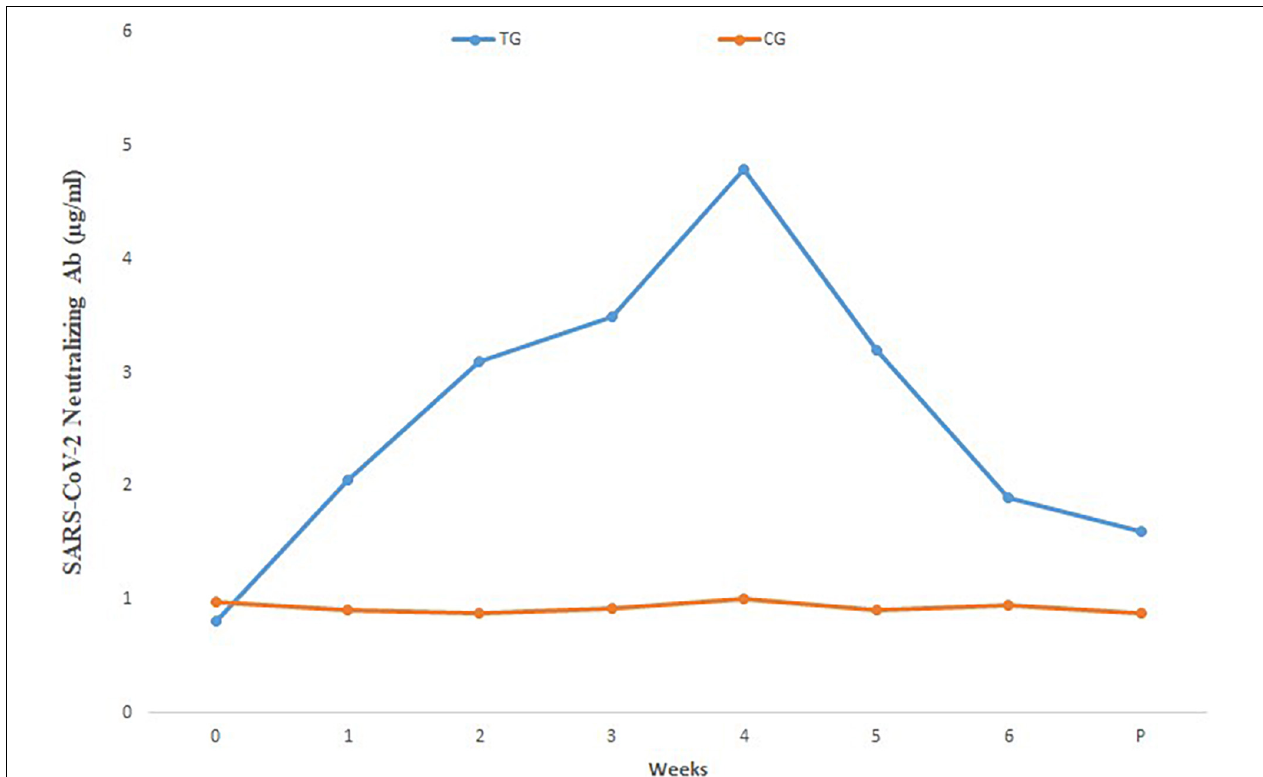
FIGURE 3 | Mean SARS-CoV-2 neutralizing antibody in different sera dilutions of six treatment and three negative control pregnant cows before and at parturition, using ELISA test. TG, Treatment group; CG, Control group; Week 0, First virus inoculation; Week 2, First booster; Week 4, Second booster; P, Parturition.